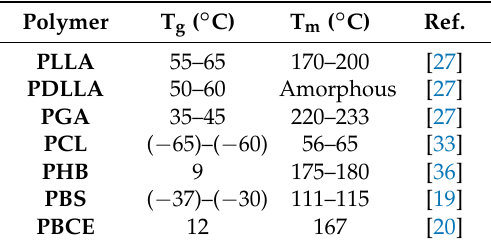
Table 1. Thermal properties of the main aliphatic